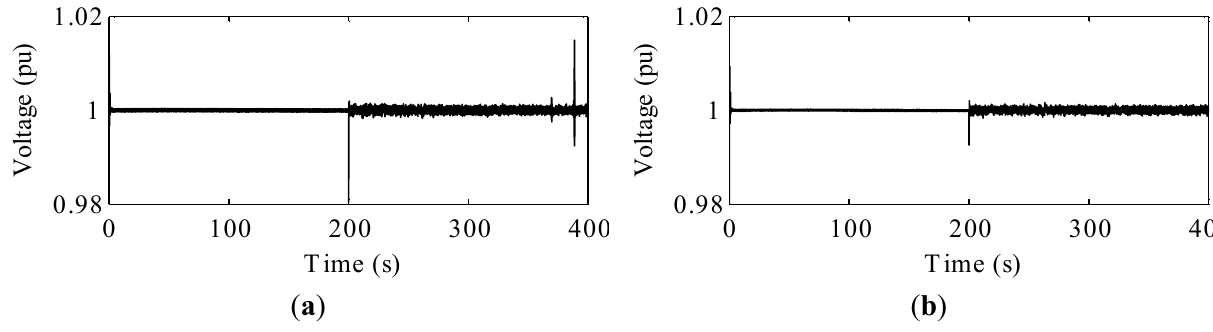
Figure 11. Voltages of the microgrid system: ( a ) microgrid with the conventional FES system; ( b ) microgrid with the proposed FES system.